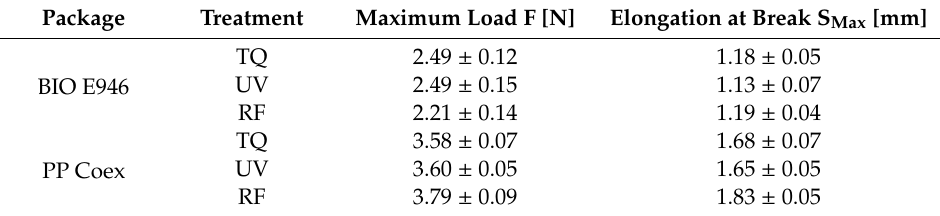
Table 2. Maximum load and elongation at break in the puncture resistance test BIO E946 and PP Coex films, original (TQ), UV and RF